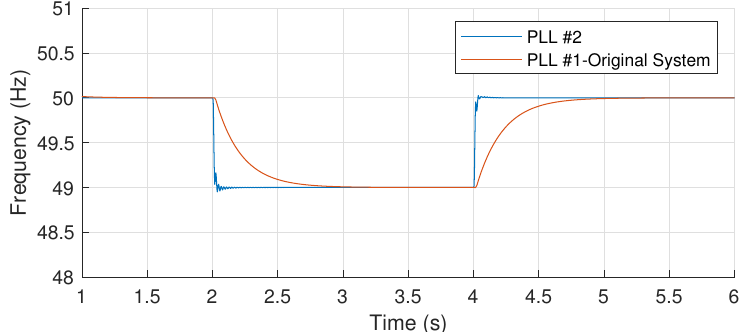
Figure 23. Estimated frequency step response of two different phase-locked loops. The frequency of contact-line voltage is changing to f = 49 Hz at t = 2 s, and going back to f = 50 Hz at t = 4 s.